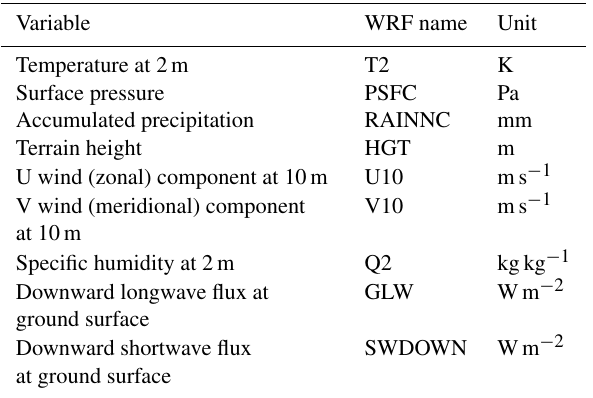
Table 3. Meteorological forcing data from the Weather Research and Forecasting (WRF) model used for